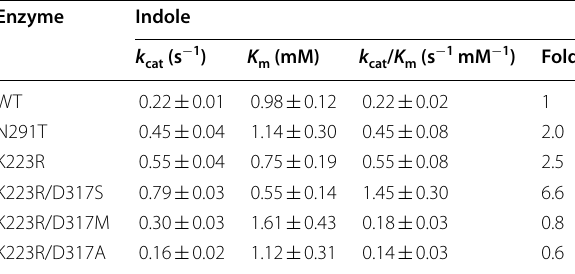
Table 1 Steady‑state kinetic parameters of bFMO and the mutants toward indole